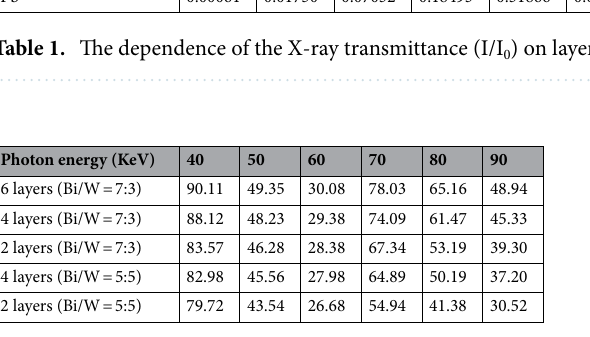
Table 2. The linear attenuation coefficient (μ cm −1 ) of the X-ray transmittance on layer thickness ratios (7:3 and